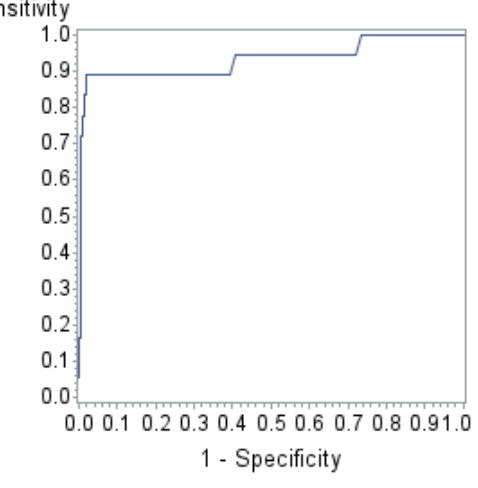
Figure 1: Logistic regression on MBI with receiver operator char- acteristic analysis, area under the curve (AUC) (c=0.933). This is a statistical analysis exercise to gain insight into the robustness of MBI findings. Here we change the threshold for positive findings from BIRADS 0 through 5 and observe the shape of the curve. AUC > 0.9 signifies a robust/excellent